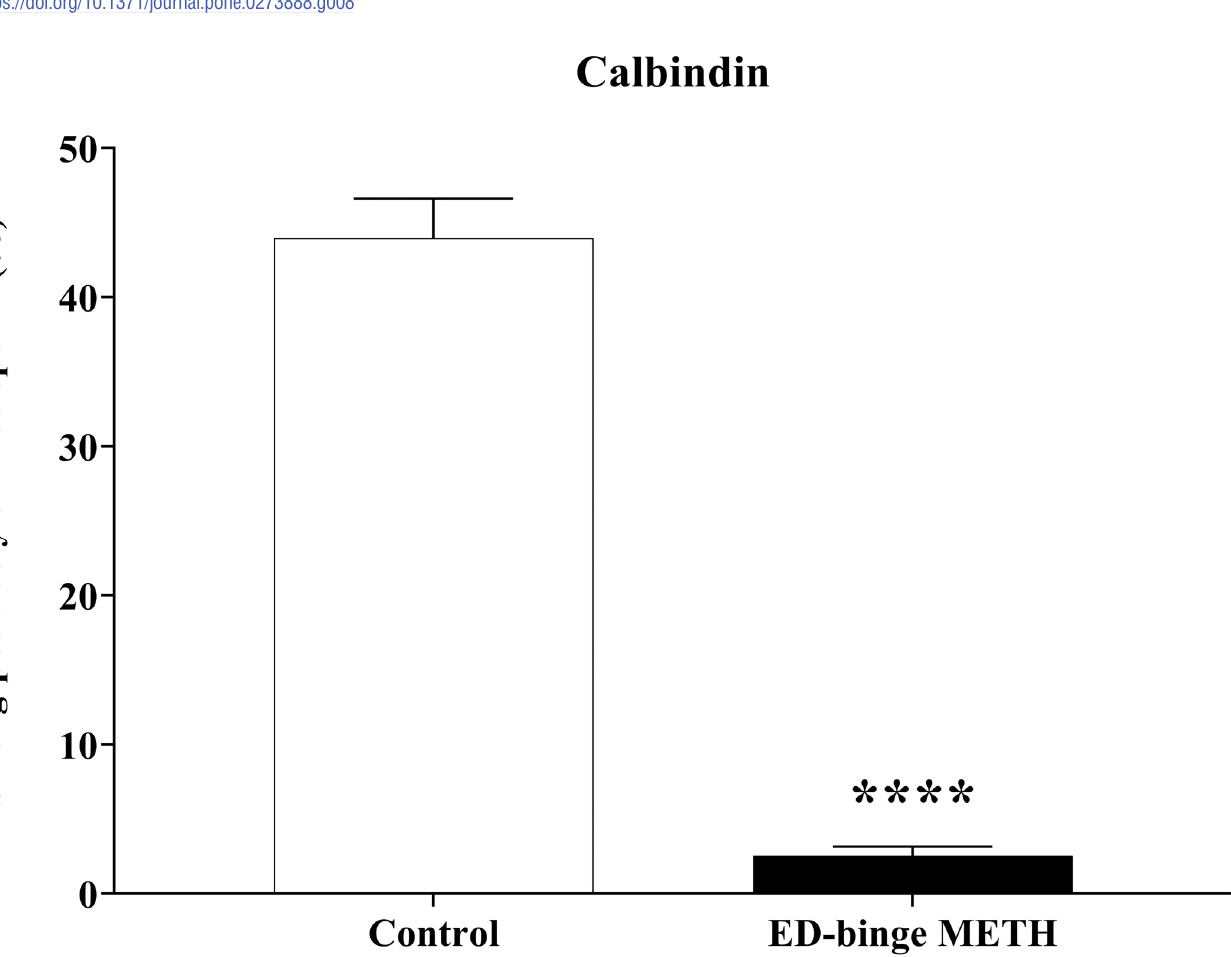
Fig 9. Percentage of strong-positively stained sperm for calbindin immunostaining (METH vs. control). Values are shown as mean ± SEM, n = 5 per group ( ���� P < 0.0001; unpaired Student’s t test).